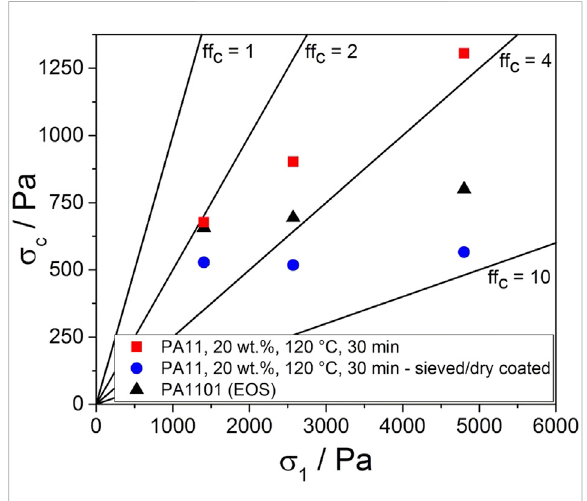
FIGURE 5 Uncon fi nedyieldstrength σ c independenceonconsolidation stresses σ 1 of PA11 powders as determined from the yield locus measured by a ring shear tester. The fl ow function ffc = σ 1 / σ c allows to quantify fl owability (reprinted from Dechet et al. (2019), Production of polyamide 11 microparticles for Additive Manufacturing by liquid-liquid phase separation and precipitation. Chemical Engineering Science 197, 11 – 25, Copyright (2019), with permission from